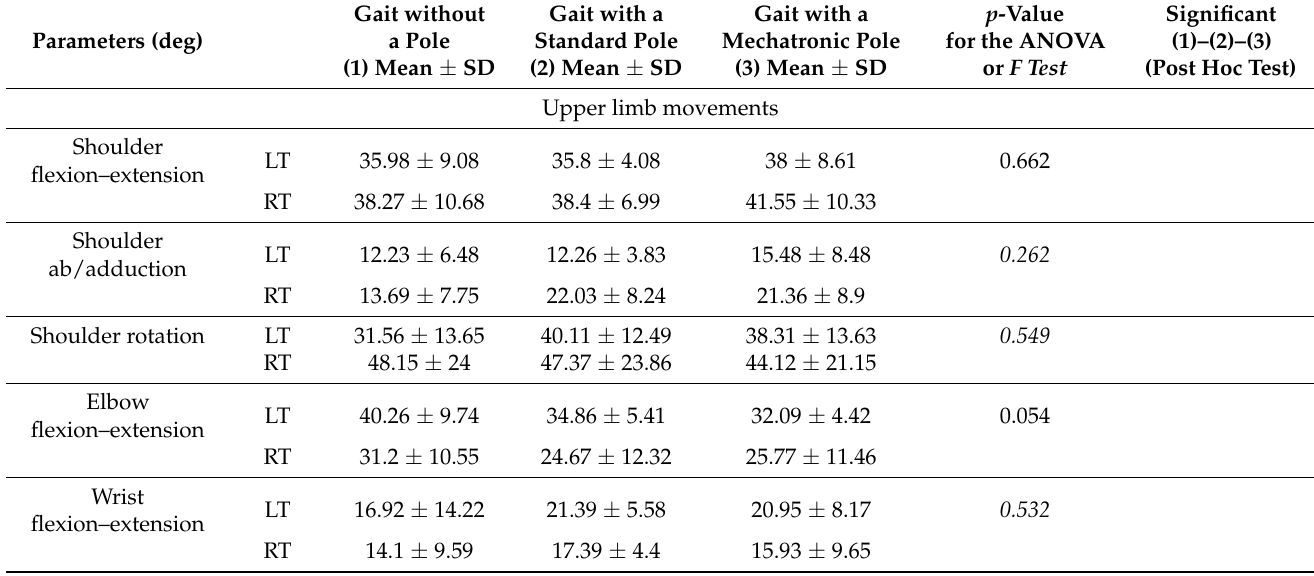
Abbreviations: SD, standard deviation; RT, right side; LT, left side. Table 3. Differences between measurements of kinematic gait parameters: without pole (1)